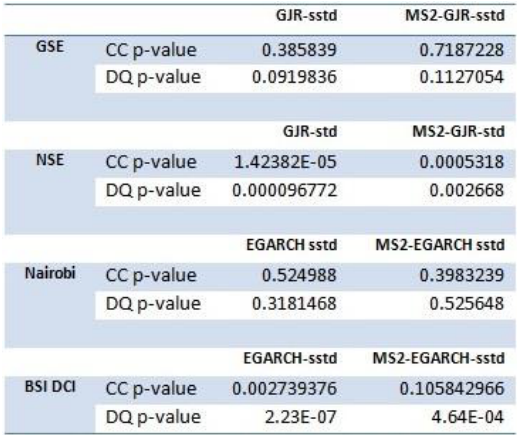
Table 10: Results of Conditional Coverage and Dynamic Quantile